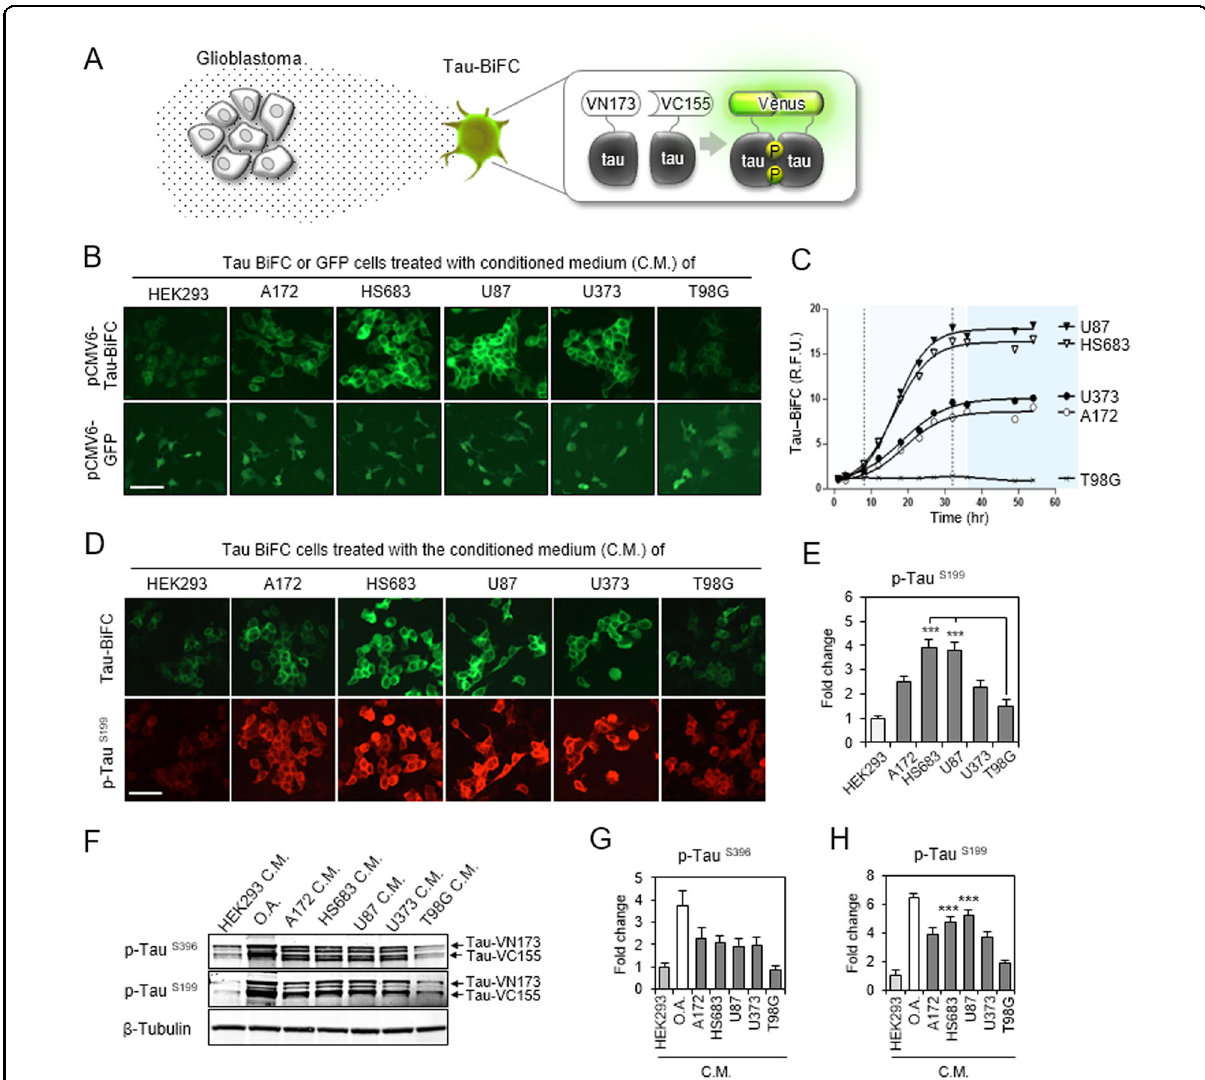
Fig. 2 Glioblastoma activates tau hyper-phosphorylation and aggregation. a Illustration of glioblastoma-secretome effect on tau-BiFC sensor cells. As a fl uorescence turn-on sensor, Venus fl uorescence turns on only when tau assembles together. b The effect of glioblastoma conditioned media (C.M.) on tau aggregation. Tau-BiFC cells were treated with glioblastoma (A172, HS683, U87, U373, or T98G) conditioned media or HEK293- conditioned medium for 48 h. Stable cells expressing GFP were tested as a negative control, indicating that glioblastoma conditioned media did not activate CMV-promoter mediated gene expression. Scale bar, 100 µm. c Quanti fi cation of tau-BiFC fl uorescence intensity. Error bars represent the standard deviations of three independent experiments. d , e Tau immuno- fl uorescence images with p-Tau (Ser199) antibody and the quanti fi cation. The signi fi cance of the experiments was determined with Student ’ s t -test. *** p < 0.001. f Immuno-blot analysis of tau phosphorylation with p-Tau (Ser396) or anti-p-Tau (Ser199). For the immuno-blot analysis, tau-BiFC cells were treated with glioblastoma-C.M for 24 h. HEK293-conditioned medium was used as a negative control and okadaic acid (O.A.) was used as a positive control. g , h Quanti fi cation of p-Tau (Ser396) and p-Tau (Ser199). Error bars represent the standard deviations of three independent experiments. The signi fi cance of the experiments was determined with Student ’ s t -test. *** p <